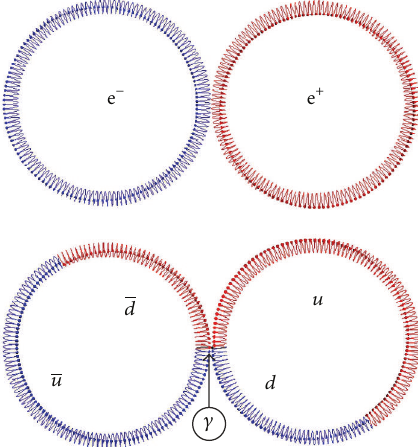
Figure 3: When high-energy protons slow down, pairs of electrons (e − ) and positrons (e + ) will materialize from quanta of actions, that is, from photons that embody the vacuum in pairs of opposite polarization. The resulting leptons are described as quantized actions in toroid forms (shown above as color coded by